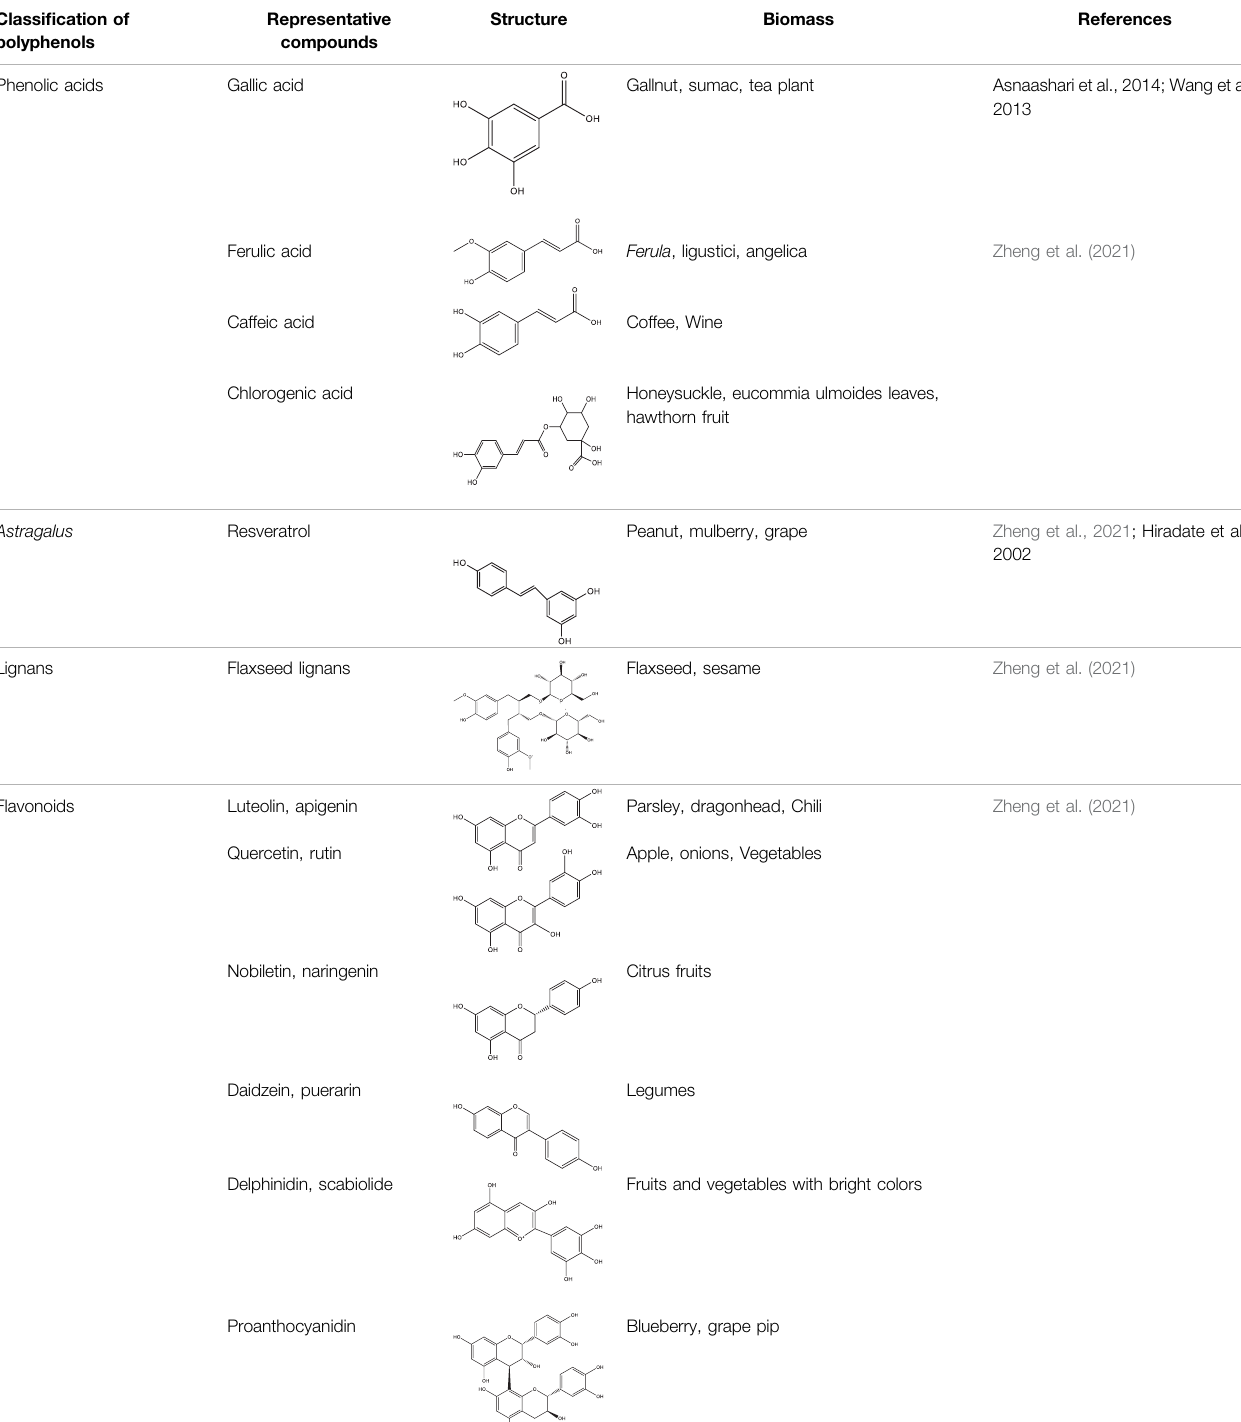
TABLE 1 | Classi fi cation of polyphenols from different